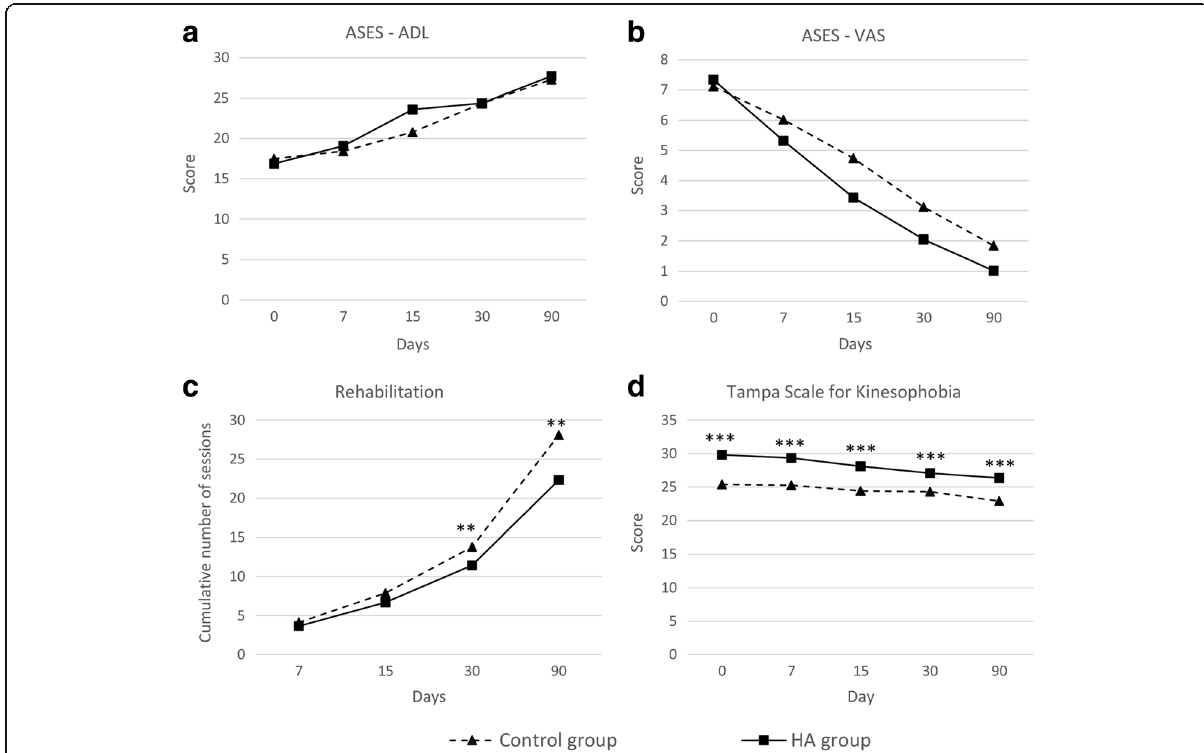
Fig. 2 Main efficacy outcomes. ASES American Shoulder and Elbow Surgeons standardized shoulder assessment form: ADL Activities of Daily Living domain ( a ), VAS Visual Analogue Scale domain ( b ). Number of rehabilitation sessions needed for recovery ( c ). Tampa Scale for Kinesophobia ( d ). ** p < 0.01 for control vs. HA groups comparison. *** p <0.001 for control vs. HA groups